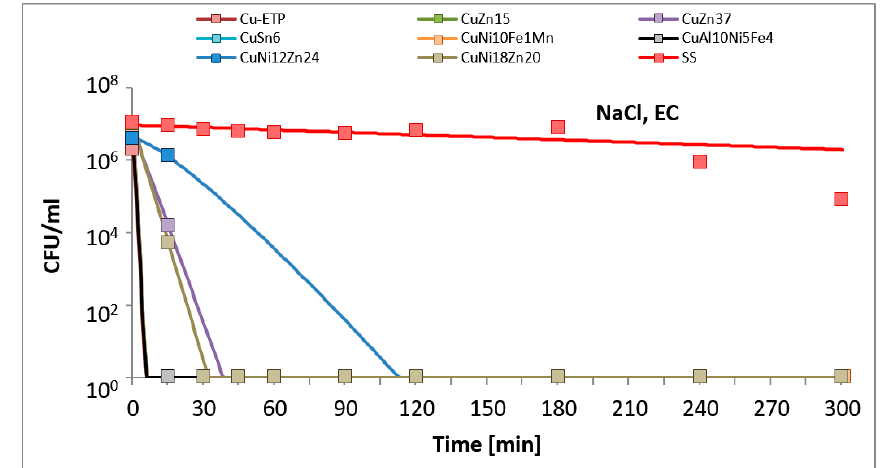
Figure 2. Escherichia coli (EC) suspension density (CFU/mL) reduction on tested metallic materials, in the variant of the experiment simulating lack of organic contamination.